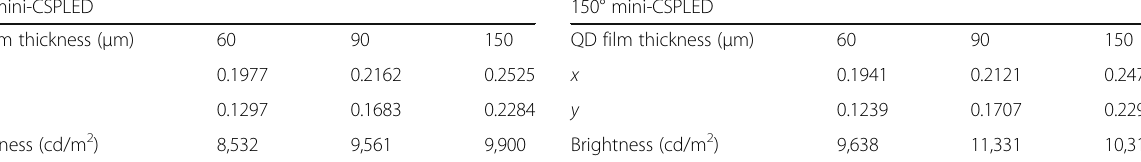
Table 2 The CIE chromaticity coordinates ( x , y ) and brightness for the 120°mini-CSPLEDs with different QD film thicknesses 120° mini-CSPLED